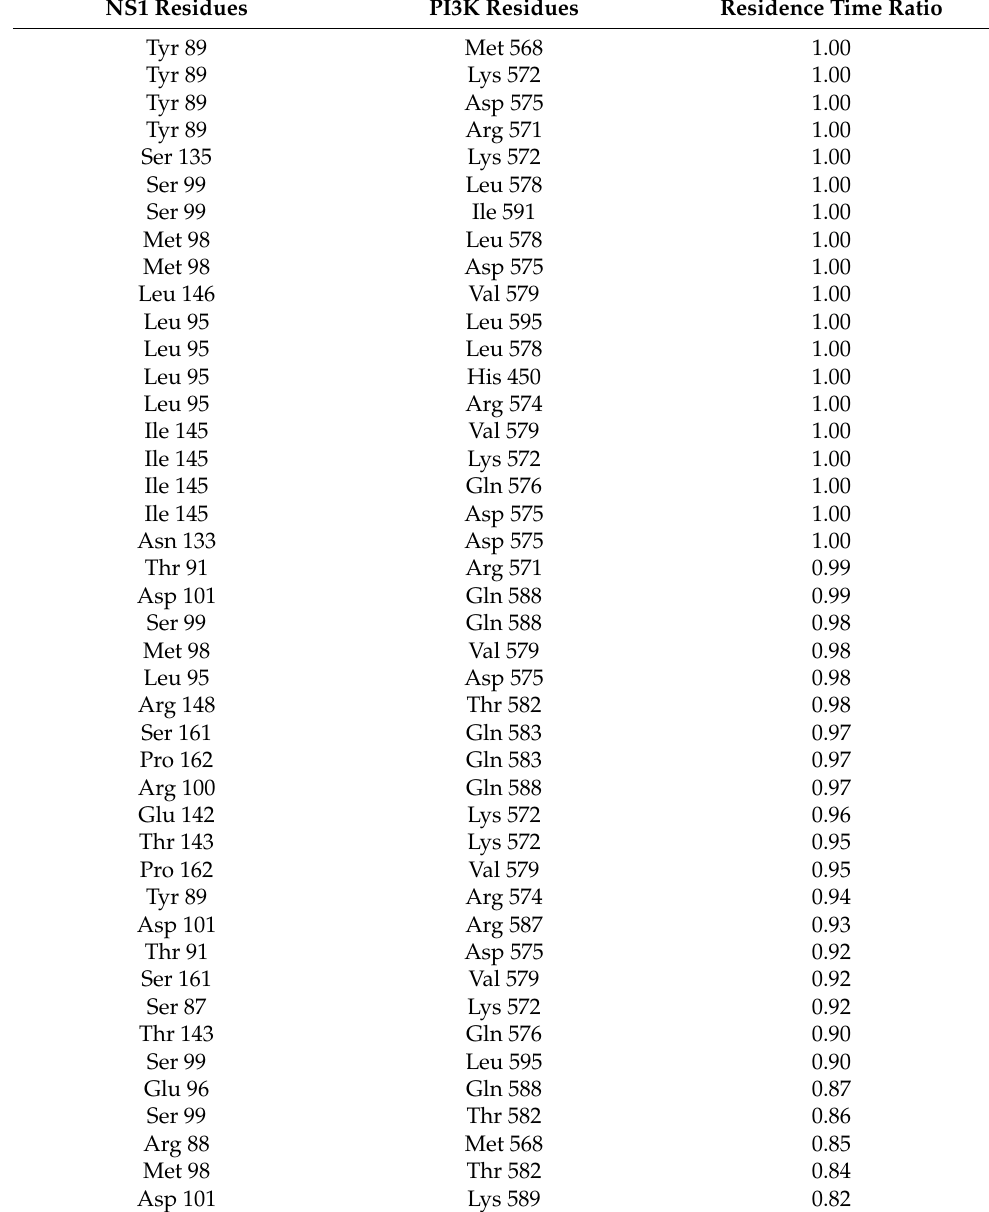
Table 3. Stable pairwise residue–residue interactions at the interface of the complex between NS1 and PI3K. NS1 Residues PI3K Residues Residence Time Ratio Tyr 89 Met 568 1.00 Tyr 89 Lys 572